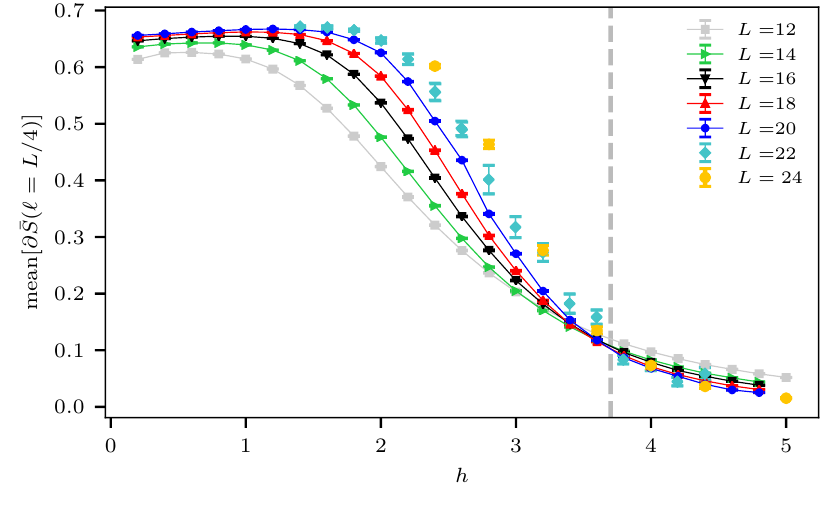
Figure 9: Behavior of the mean of the slope of the entanglement entropy computed for the quarter cut L / 4 as a function of disorder, for different system sizes. Data for L ≤ 22 are extracted from Ref. [ 47 ]